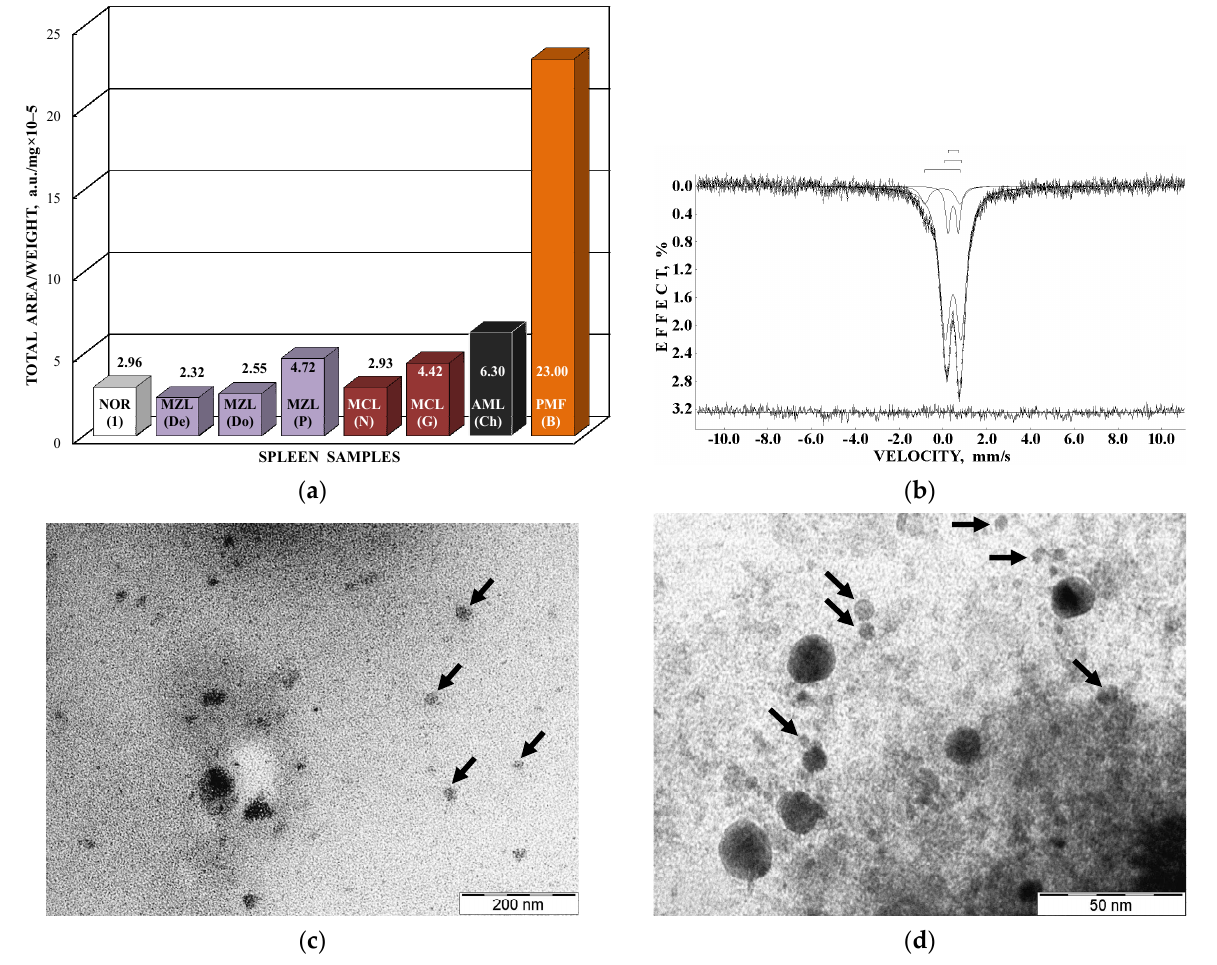
Figure 18. Plot of the total areas of ferritin‑like components 1 and 2 in the Mössbauer spectra of spleen tissues from healthy human and patients with hematological malignancies normalized by the sample weight ( a ), the Mössbauer spectrum of spleen tissue from patient “B” with primary myelofibrosis measured at 90 K and fitted using three quadrupole doublets, the differential spectrum is shown on the bottom ( b ) and transmission electron microscopy images of spleen tissues from healthy human “1” ( c ) and patient “B” with primary myelofibrosis ( d ), possible ferritin iron cores are indicated by arrows in ( c , d ). Adapted from Ref. [55] with permission from Springer Nature: Biometals,